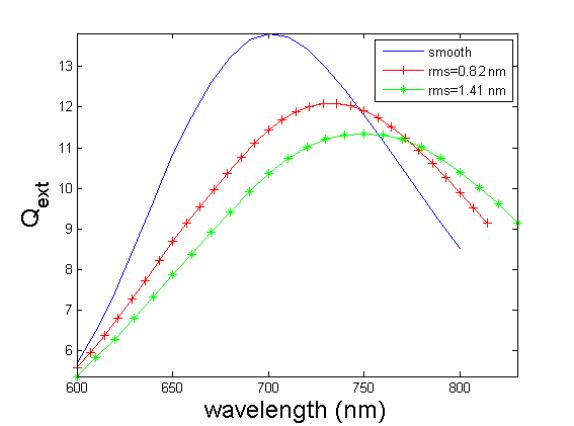
Figure 6: Extinction efficiency spectra of nanoantenna- based biosensor for smooth (blue curves) and rough topog- raphy.